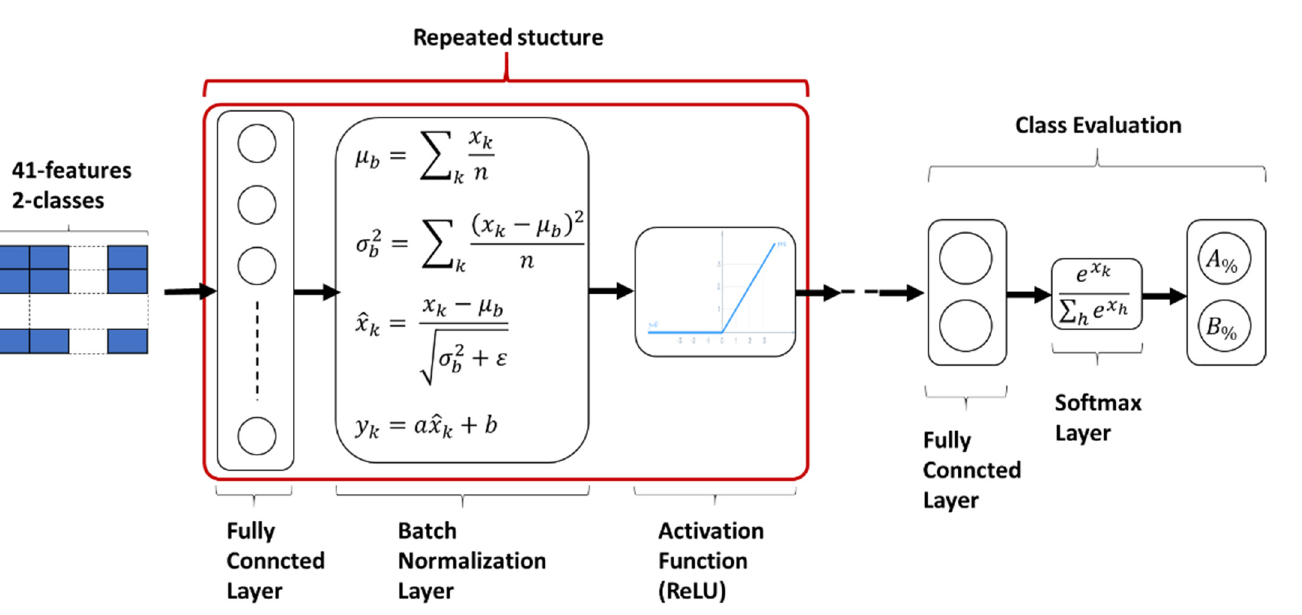
Figure 9. Artificial neuron architecture.